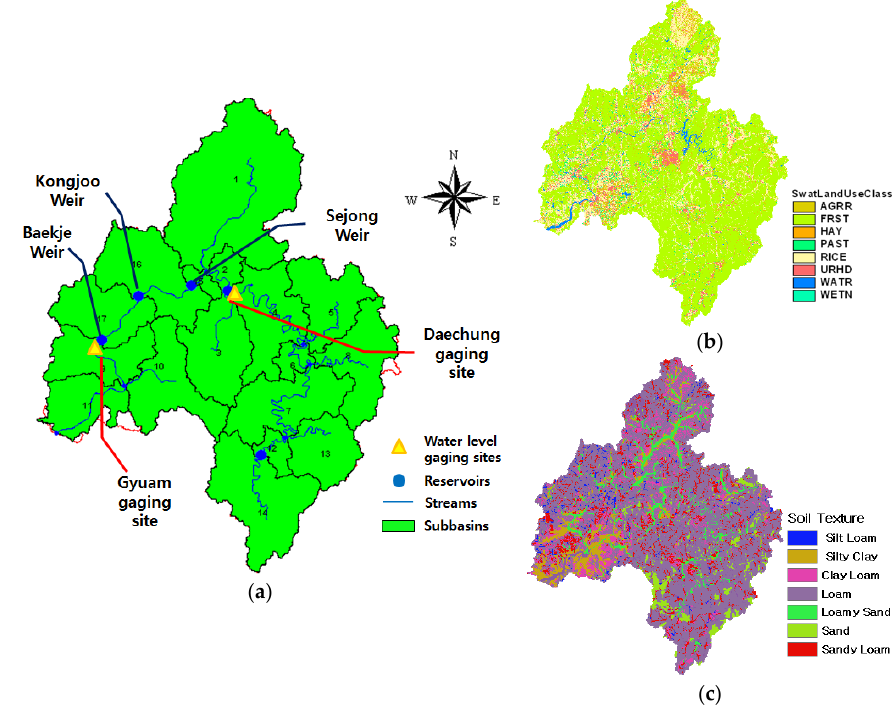
Figure 4. Geographic Information System (GIS) data as SWAT input. ( a ) Streams and subbasins; ( b ) Land use map; ( c ) Soil type map.